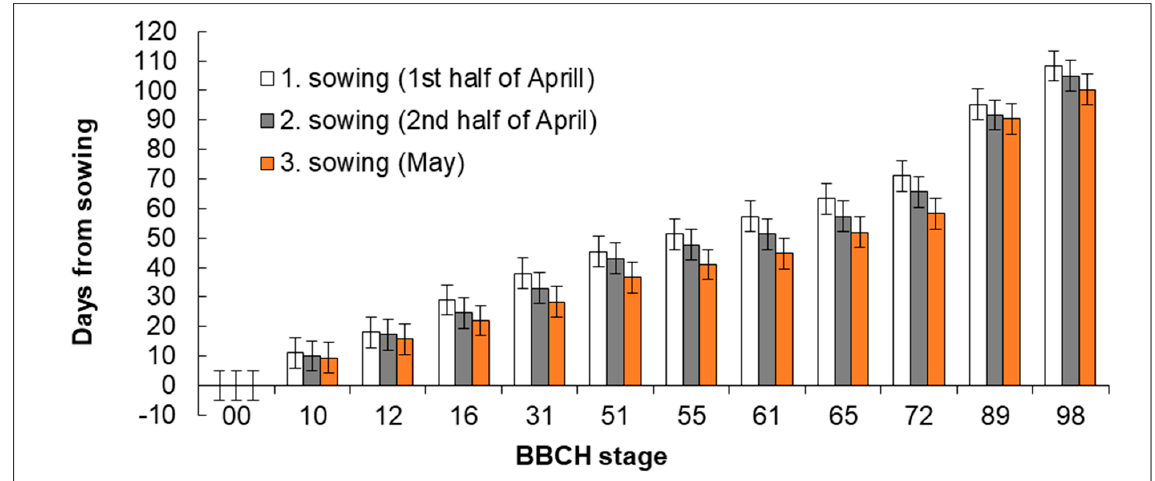
Figure 2. Effect of sowing date on the number of days for reaching the respective developmental stages. Mean values ( n = 9) of individual variants are shown for the specific developmental stage (BBCH) in three years of study ± SD. Different letter indices are present only in variants in which significant differences were found ( p < 0.05). If no letter indices are included, no significant difference was found between the respective variants.